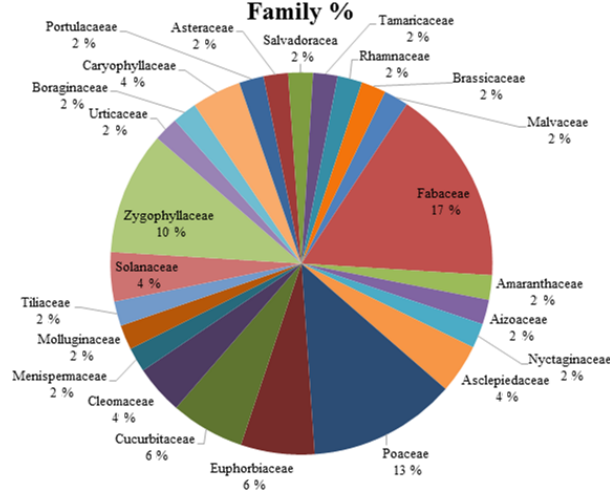
Figure 4. Floristic richness and diversity in the studied